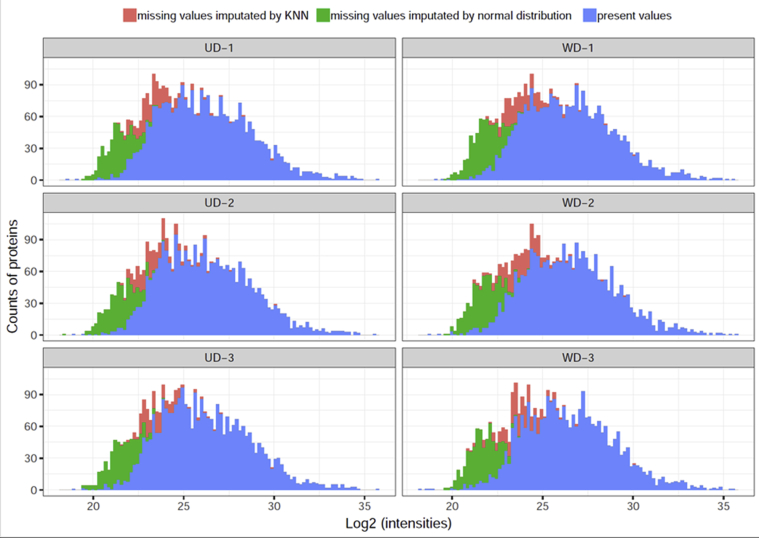
Distribution of protein intensities in 6 samples of well-differentiated normal human primary bronchial/tracheal epithelial cells and un-differentiated cells. UD and WD: un-differentiated and well-differentiated normal human primary bronchial/tracheal epithelial cells.